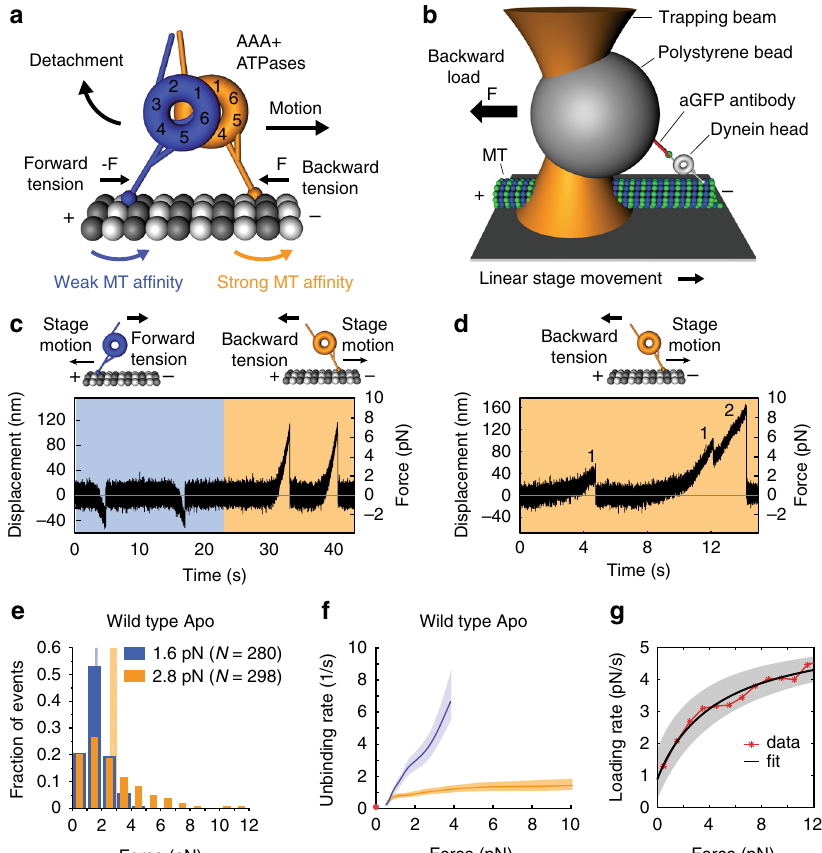
Fig. 2 Dynein-MT bond anisotropy. a Model for tension-based regulation of dynein stepping. Splaying of the dynein heads generates intramolecular tension. Under backward tension (front head) MT-binding strength is greater, and under forward tension (rear head) it decreases. b A polystyrene bead bearing a dynein MD is held in an optical trap as the microscope stage sweeps back and forth parallel to a MT (not to scale). c Force (position) vs. time for WT dynein (GFP-Dyn1 331kDa ) in the apo state (see “ Methods ” section) acquired under non-reducing conditions. Orange and blue areas are periods of applied backward and forward tension, respectively. d Primary and secondary unbinding events. Event 1 is a primary event, beginning from zero force ( F start = 0). Secondary events (2) occur when the MD rebinds the MT before returning to the trap center, and thus F start > 0. e Normalized histograms of primary forward (blue) and backward (orange) unbinding forces, with mean values noted (we plot the absolute force values to facilitate comparison of the unbinding-force distributions in both loading directions). Vertical bands are 95% CIs of the mean (forward: [1.5, 1.7] pN, backward: [2.5, 3.0] pN) estimated by bootstrapping 4,000 samples (source data are provided as a Source Data fi le). f Unbinding rate vs. force derived from the data in ( e ). The shaded areas are 95% CIs for the mean rates, estimated by bootstrapping. The depicted zero-load unbinding rate of 0.086 ± 0.002 s − 1 (±SE, red circle) represents the inverse of the time constant obtained from the analysis of the experimental CDF of the MT-bound lifetimes measured via TIRF microscopy (Supplementary Fig. 2a) (the 95% CIs of the measured unbinding rate (lower limit, 0.084/s; upper limit, 0.11/s) are not shown as they are shorter than the height of the symbol). g Loading rate vs. force obtained from line fi ts to the 200-ms data segment before detachment of each measured unbinding-force event (see Supplementary Fig. 3 for underlying